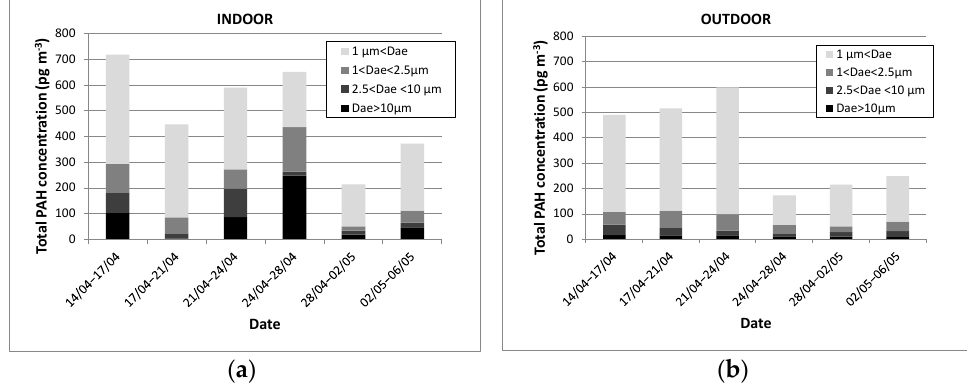
Figure 4. Indoor ( a ) and outdoor ( b ) total PAH concentrations ( µ g m − 3 ) measured in 2014 vs. time and particle size.